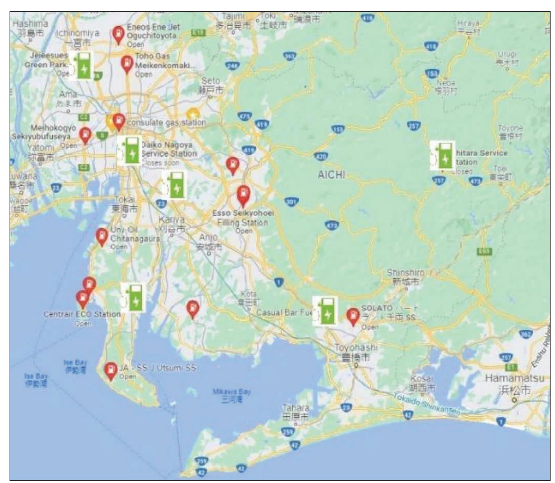
Figure 7: EVCS locations (model M